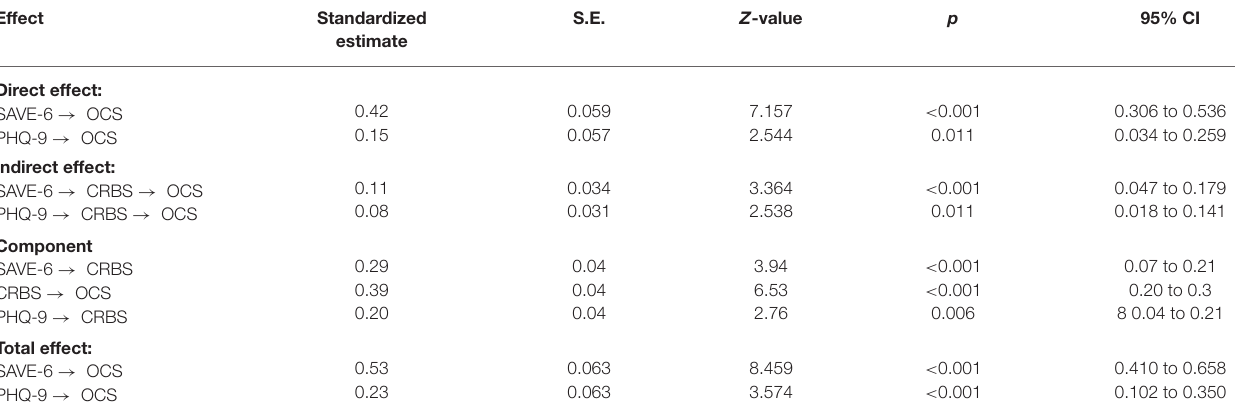
TABLE 4 | The results of direct, indirect, and total effects on mediation analysis. Effect